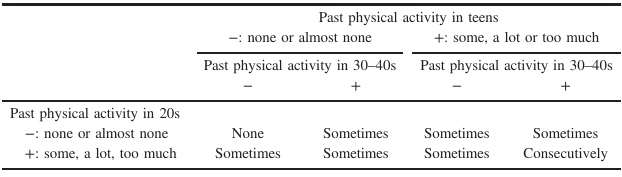
Table 1. Classi fi cation by past physical activity